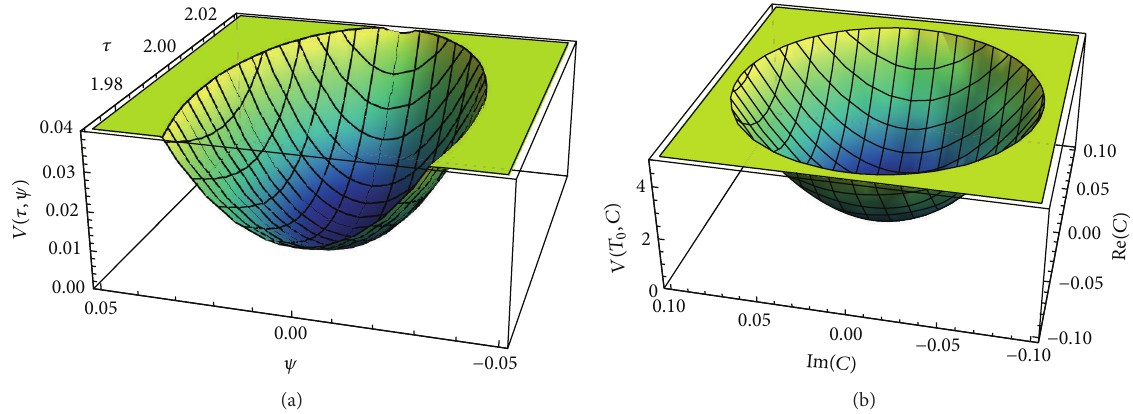
Figure 2: The minimum of the potential of the scenario [13] at 𝑇 = 2 , 𝐶 = 0 . (a) corresponds to 𝑉(𝑇, 0) rescaled by 1/𝜖 2 and (b) corresponds to 𝑉(𝑇 0 ,𝐶) rescaled by 10 4 /𝜖 2